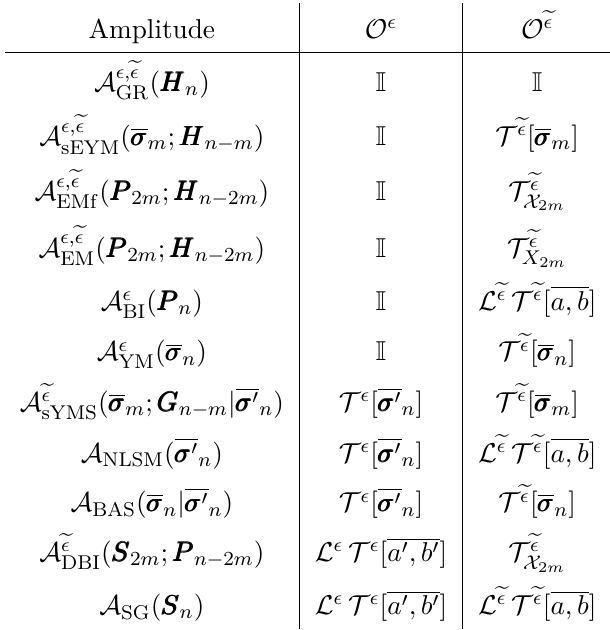
Table 3 . Unifying relations for differential operators at tree